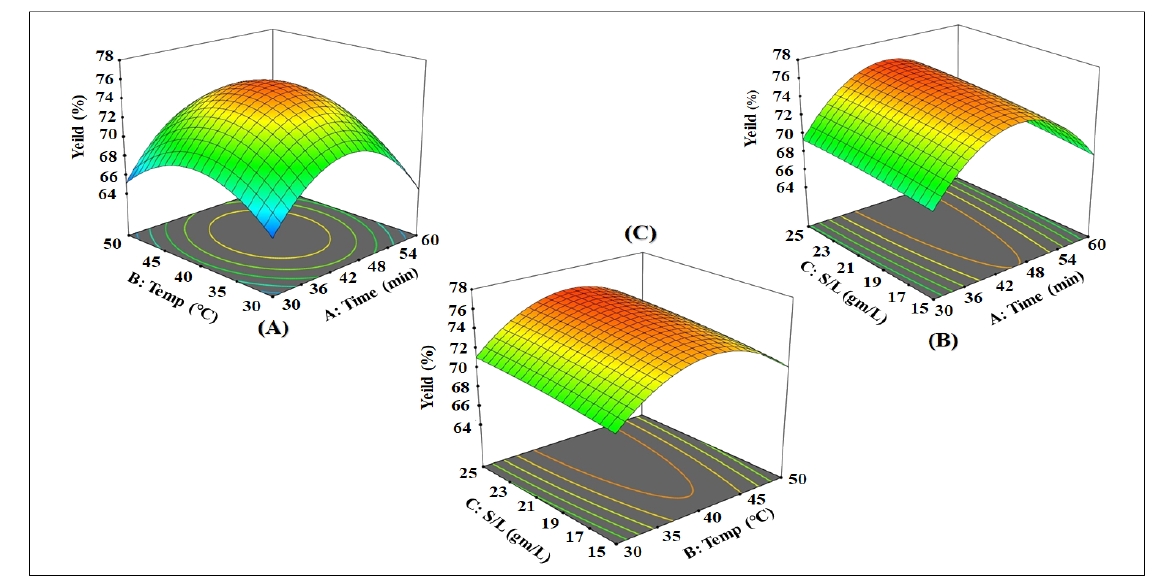
Figure 1. 3D plots representing the effects of ( A ) extraction time and temperature, ( B ) temperature and solid–liquid ratio, and ( C ) extraction time and solid–liquid ratio on the yield. ( A ), extraction time; ( B ), temperature; and ( C ), solid–liquid ratio.